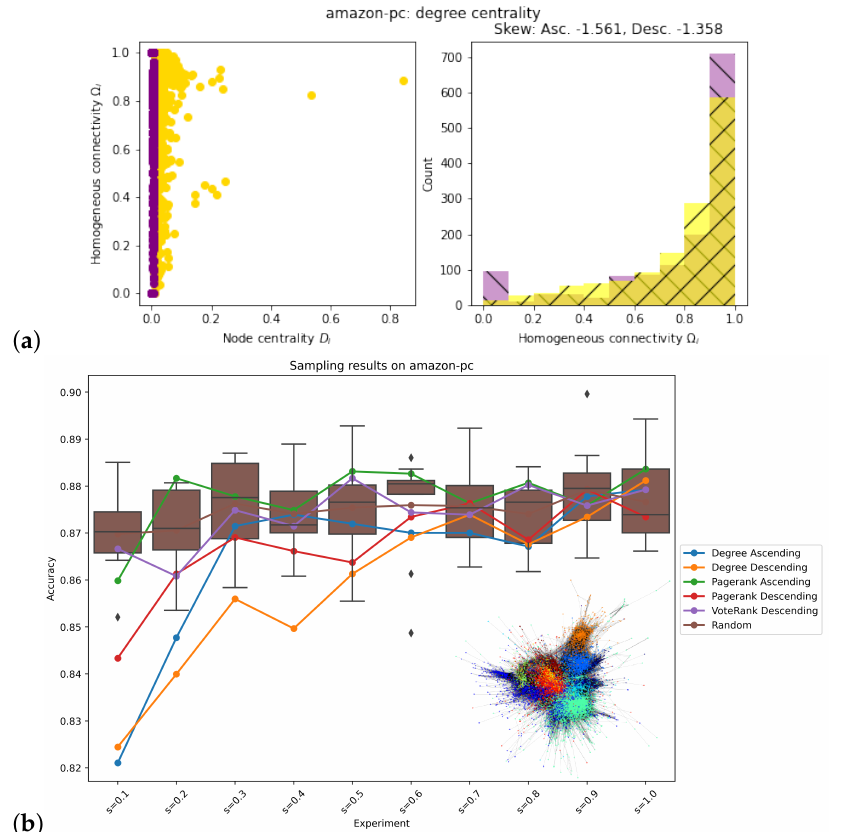
Figure A1. Panel ( a ) shows degree centrality plots where the left figure presents scatter plots of node degree centrality D i against node homogeneous connectivity Ω i on the training data of amazon-pc. The upper half of nodes according to their centrality are colored in yellow while the lower half is presented in purple. The histogram on the right visualizes the distribution of homogeneous connections. The skew for each subset’s distribution is annotated above the right graph. Panel ( b ) presents the sampling result on the training data of amazon-pc. Observing panel ( b ), random sampling appears almost uniformly